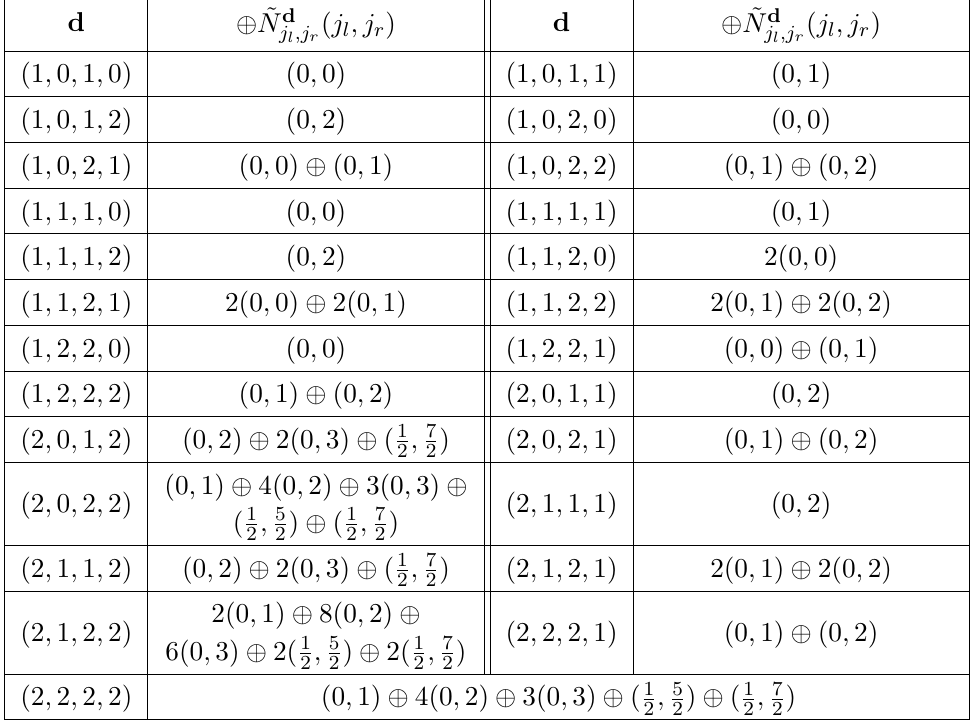
Spectrum of the Wilson loop states in the anti-symmetric representation in the SU(4) 6 theory for d i ≤ 2 . Here, d = ( d 1 , d 2 , d 3 , d 4 ) labels the BPS states with fugacity Q Q d Q − 1 / 2 Q − 1 Q − 1 / 2 i 2 3 4 i